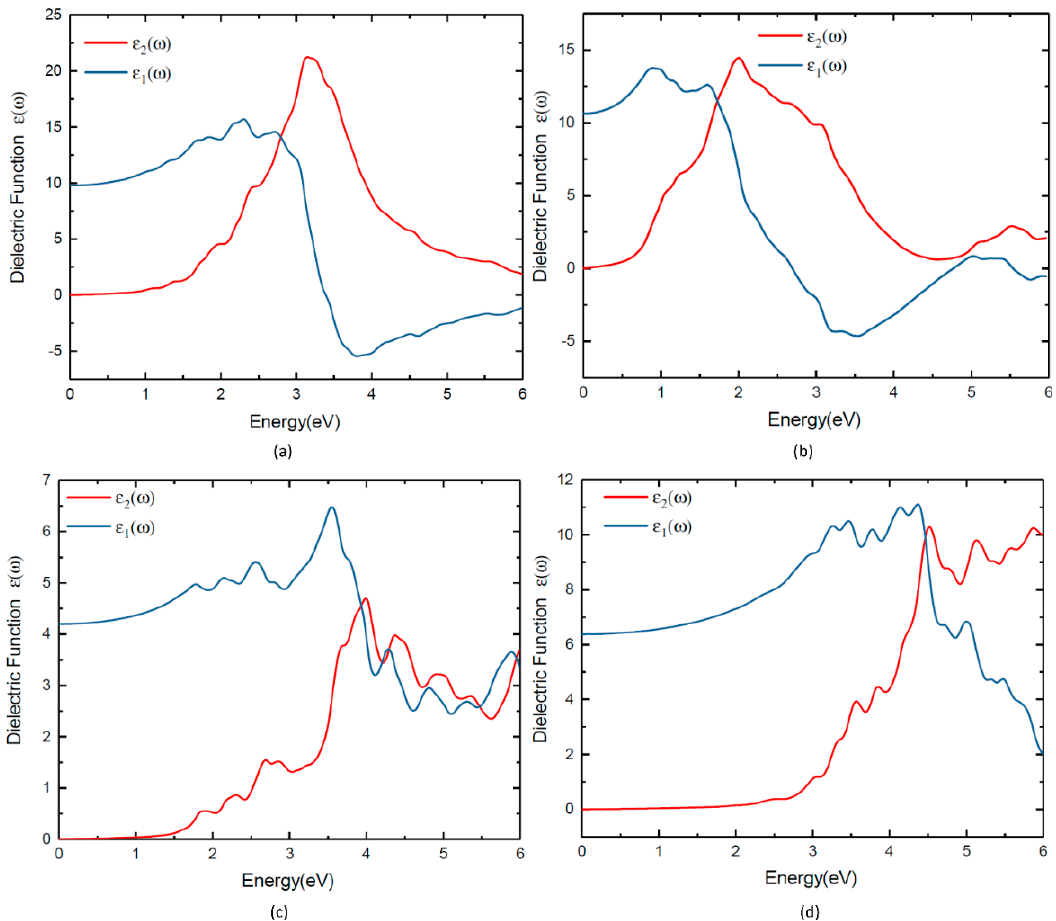
Figure 7. Dielectric function of ( a ) TlBiS 2 , ( b ) Ba 3 BiN, ( c ) Ag 2 BaS 2 and ( d ) ZrSO.